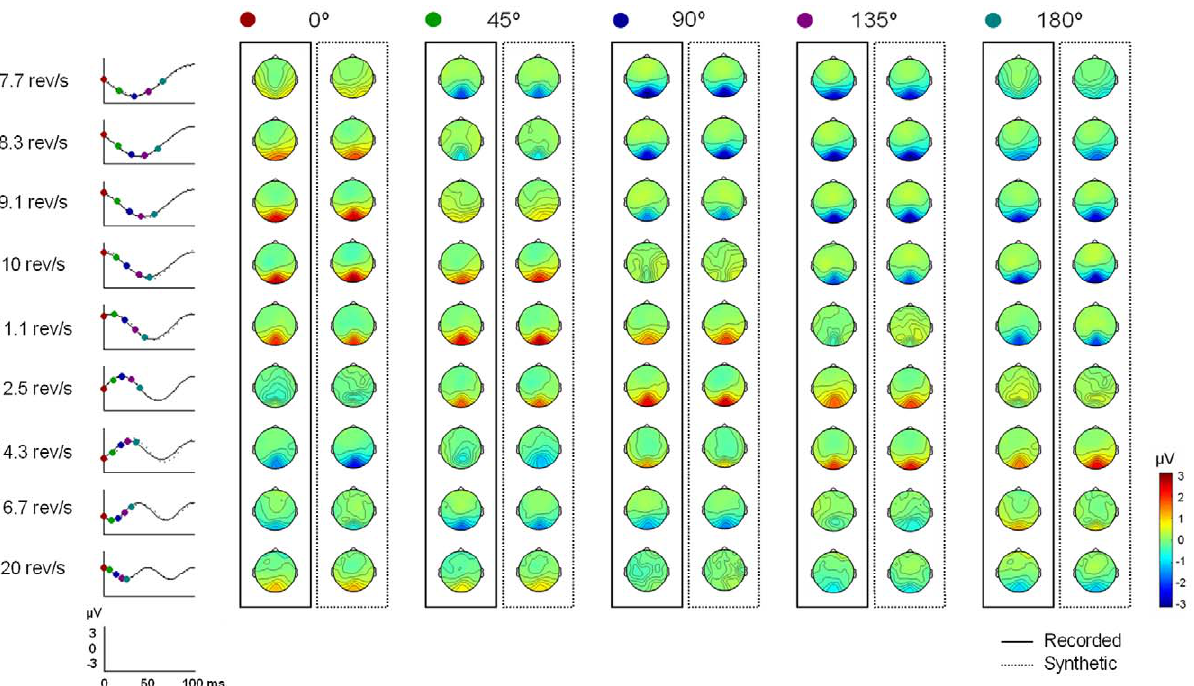
Figure 8. Voltage topography for both recorded and synthetic data (Experiment 2). Scalp voltage topographies for the dominant frequency of each condition (rows) and phase angle (columns) from 0 u to 180 u . Recorded topographies are presented in the solid boxes; synthetic topographies, in the dashed boxes. The time points corresponding to each phase angle are indicated by its corresponding colour in the time courses of the frequency amplitude at Oz shown on the left side. Phase angles are referred to stimulus onset (i.e. 0 u phase angle corresponds to 0 ms).